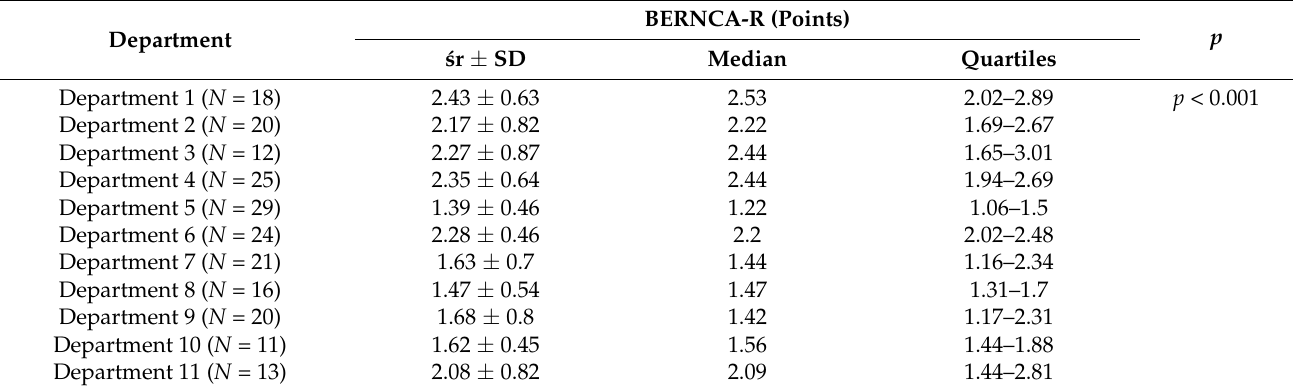
Table 3. Nursing care rationing—comparison of all surveyed medical care